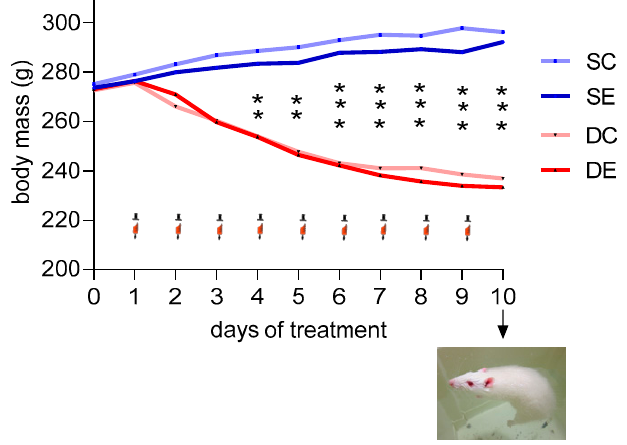
Figure 1. The effects of Dex treatment, swimming, and a combination of these factors on body mass during ten days observation. Body mass was measured daily for the entire experiment in saline-treated, non-exercised (SC), saline-treated, exercised (SE), Dex-treated, non-exercised (DC) and Dex-treated, exercised (DE) groups of rats. —Dex or saline injection, on the 10th day of the experiment,